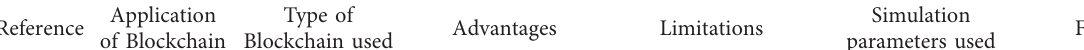
Table 7: Various proposed frameworks for healthcare based on Blockchain and